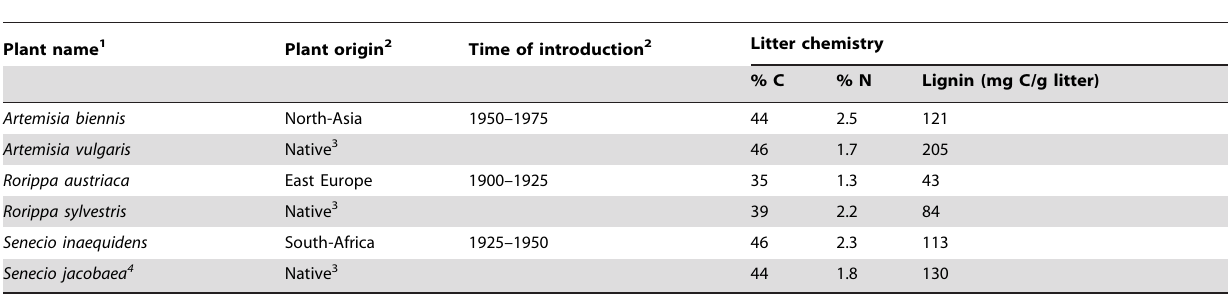
Table 1. Plant species used in